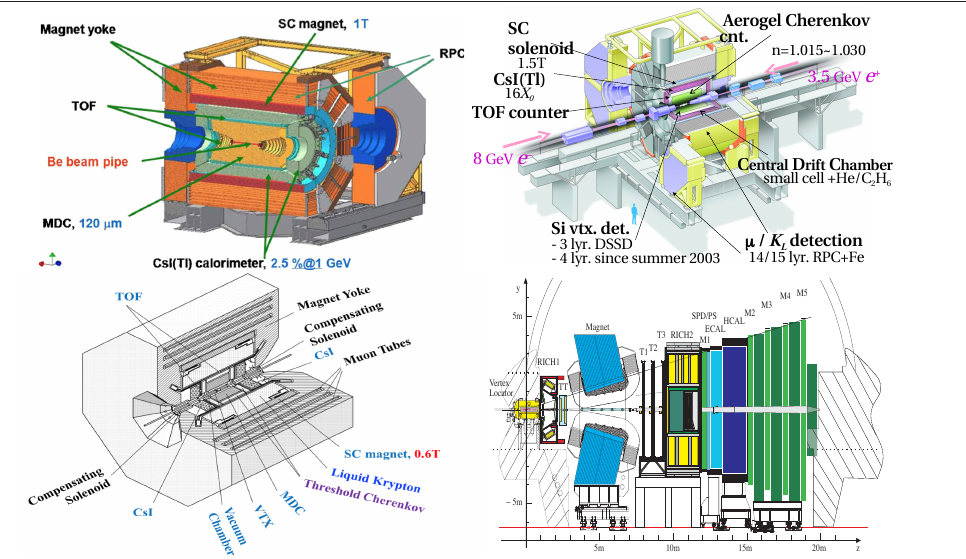
Figure1.1: ReoptimizedLHCbdetectorlayout,showingtheVertexLocator(VELO),thedipolemagnet, thetwoRICHdetectors,thefourtrackingstationsTTandT1–T3,theScintillatingPadDetector(SPD), Figure 1. Schematic drawing of the detectors for BESIII (Top left) [7], Belle (Top right) [14], KEDR Preshower(PS),Electromagnetic(ECAL)andHadronic(HCAL)calorimeters,andthefivemuonstations (Bottom left)[17] and LHCb (Bottom right) [19] showing its main components.